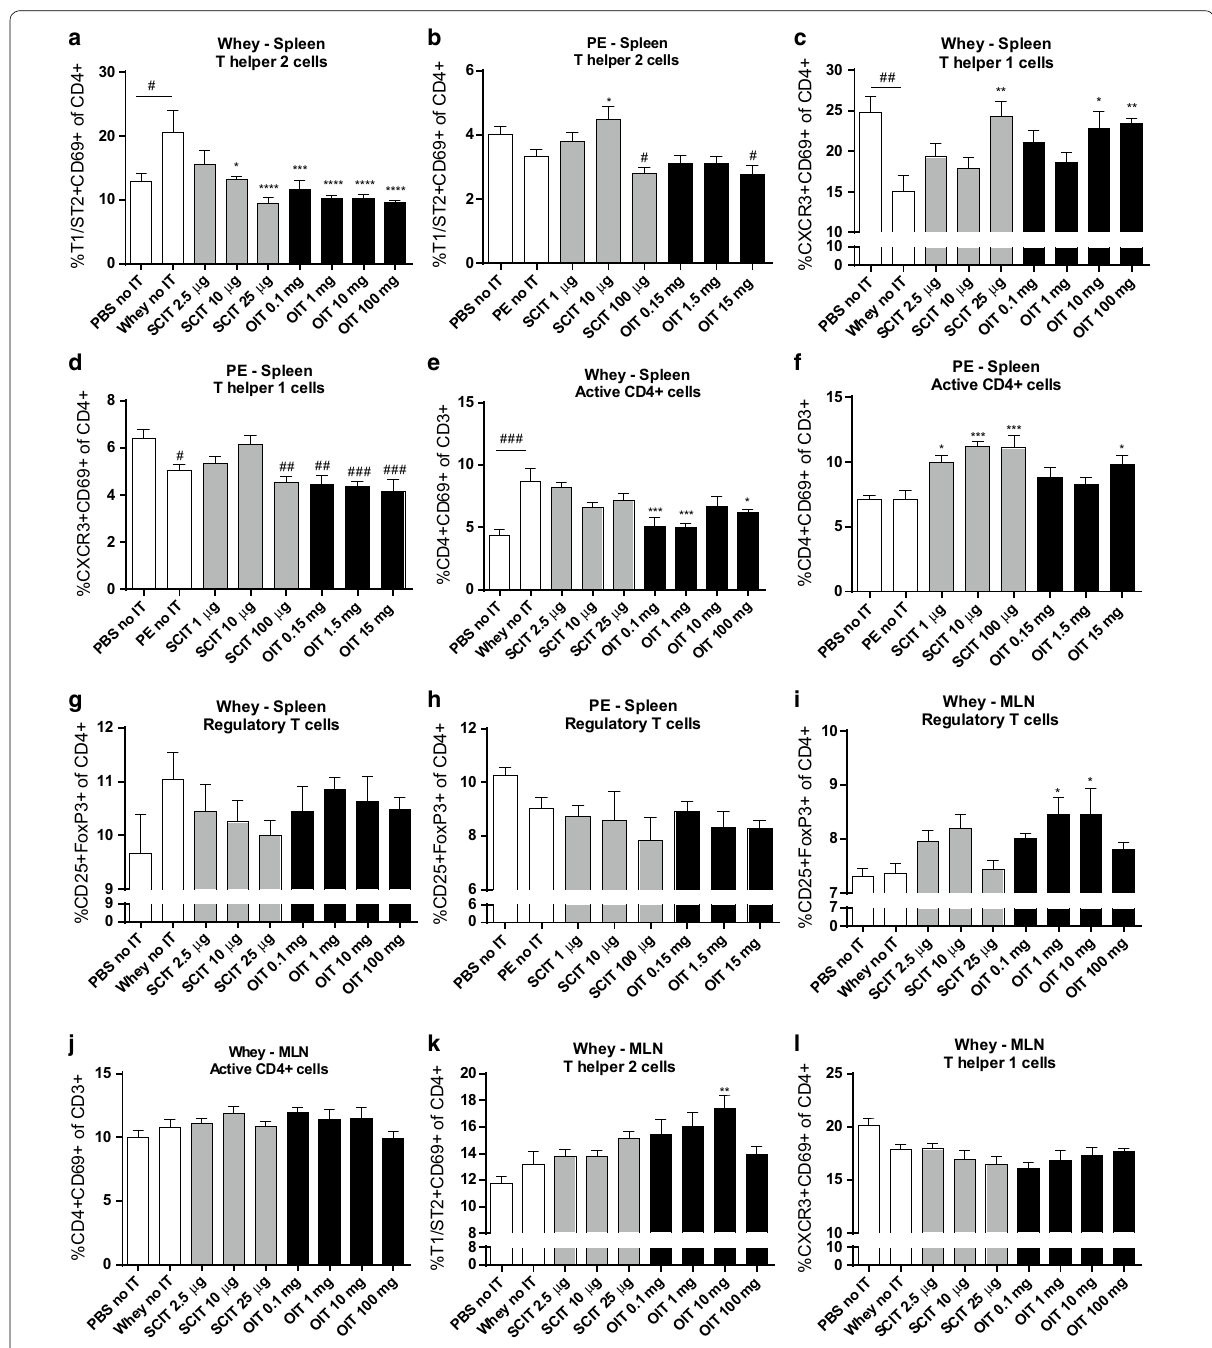
Fig. 4 Flow cytometric analysis of T cell populations in the spleen and MLN. Cells were gated based on FSC–SSC properties and the Fluorescence- minus-one (FMO) technique. a , b Percentage of activated Th2 cells (T1/ST2 CD69 of CD4 ) in spleen. c , d Percentage of activated Th1 cells + + + (CXCR3 CD69 of CD4 ) in spleen. e , f Percentage of activated CD4 cells (CD4 CD69 of CD3 ) in spleen. g , h Percentage of Tregs (CD25 + + + + + + + + FoxP3 of CD4 ) in spleen. i Percentage of Tregs (CD25 FoxP3 of CD4 ) in MLN of CMA animals. j Percentage of activated CD4 cells (CD4 + + + + + + + CD69 of CD3 ) in MLN of CMA animals. k Percentage of activated Th2 cells (T1/ST2 CD69 of CD4 ) in MLN of CMA animals. l Percentage of + + + + + activated Th1 cells (CXCR3 CD69 of CD4 ) in MLN of CMA animals. All data are represented as mean SEM n 6/8 mice/group. Statistical anal- + + + ± = ysis was performed using one-way ANOVA and Dunnett’s post hoc test for multiple comparisons. # P < 0.05; ## P < 0.01; ### P < 0.001; #### P < 0.0001 compared to sham control control. *P < 0.05; **P < 0.01; ***P < 0.001; ****P < 0.0001 compared to whey- or PE-sensitized control. PE, peanut extract; OIT, oral immunotherapy; SCIT, subcutaneous immunotherapy; IT,